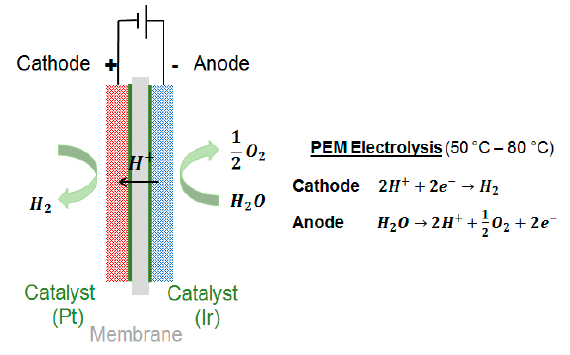
Figure 2. PEM electrolytic cell.